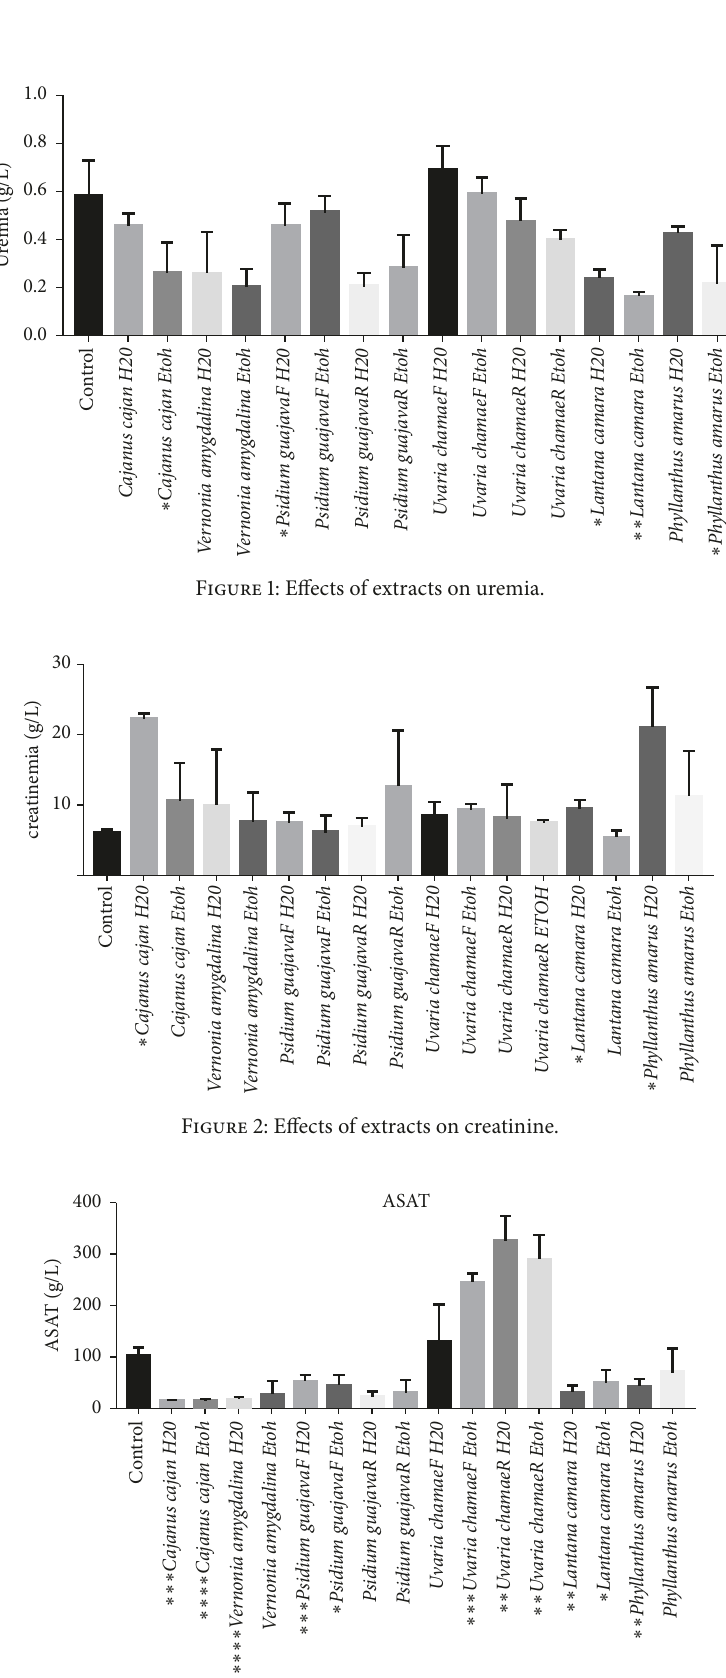
Figure 3: Effects of extracts on aspartate